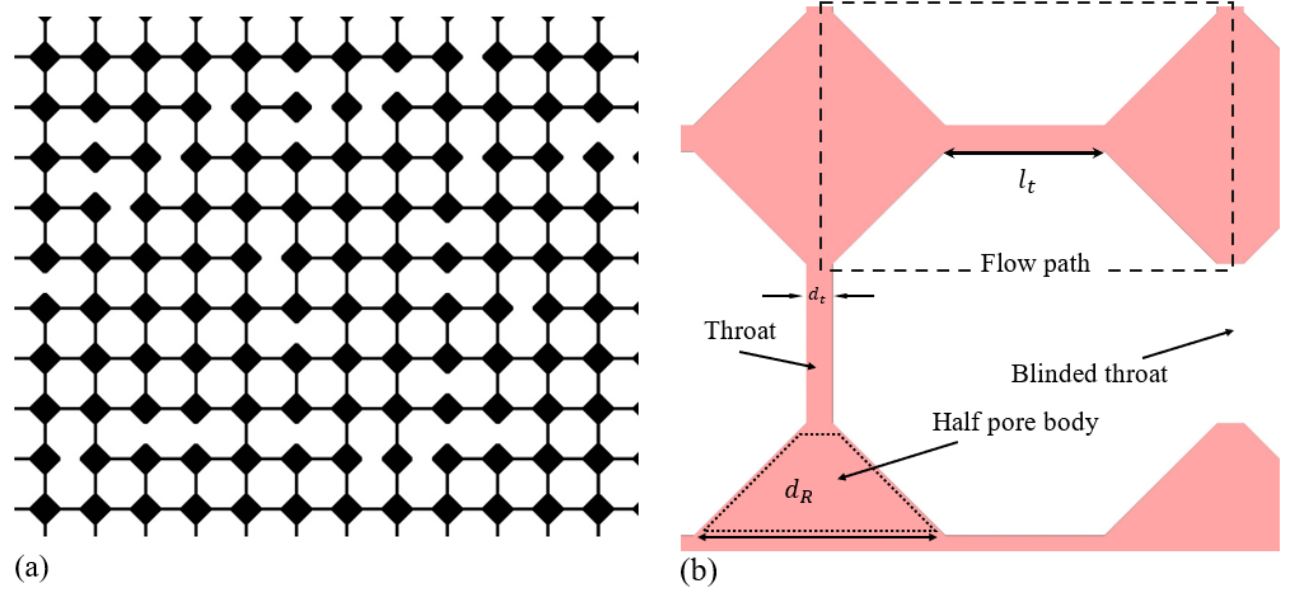
Figure 1. ( a ) The schematic of the generated 30 × 30 pore network; ( b ) definition of the utilized terminology.